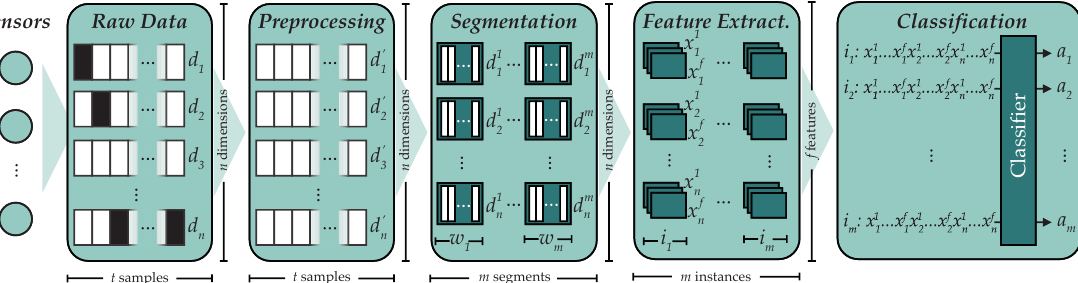
Figure 1. The five steps contained in the activity recognition chain: acquisition, preprocessing, segmentation, feature extraction and classification (extracted from Ref.